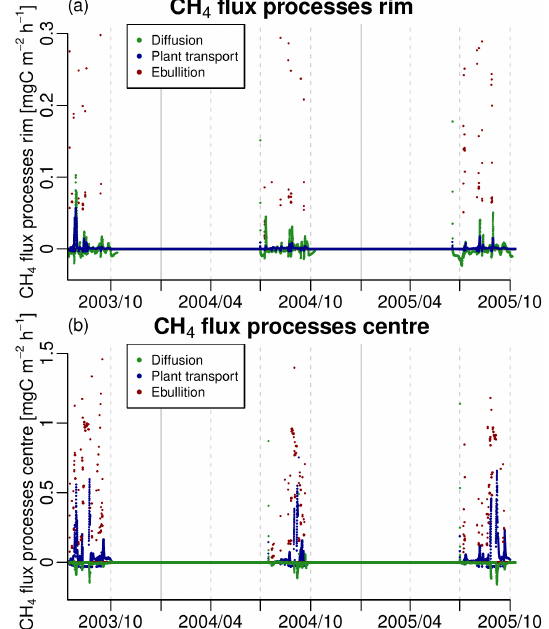
Figure 4. Modelled methane flux out of the soil at the (a) rim and (b) centre, split into the different transport processes. Solid lines indicate 1 January; dashed lines indicate 1 April, 1 July and 1 Oc- tober of the respective year. Please note the different scales. Be- cause of the wide spread of high values, to as high as 39.3 (a) and 86.6 (b) mg Cm − 2 h − 1 , a portion of 0.108% (a) and 0.0609% (b) values was cut to provide reasonable pictures. The minima of the values are − 0 . 0234 (a) and − 0 . 158 (b) mg Cm − 2 h − 1